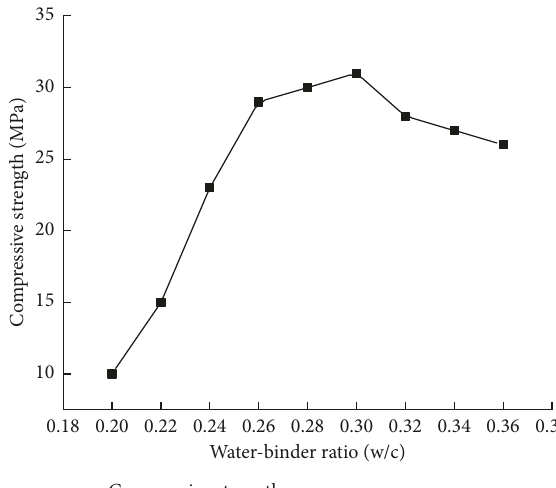
Figure 8: Relationship between water-binder ratio and com- pressive strength.